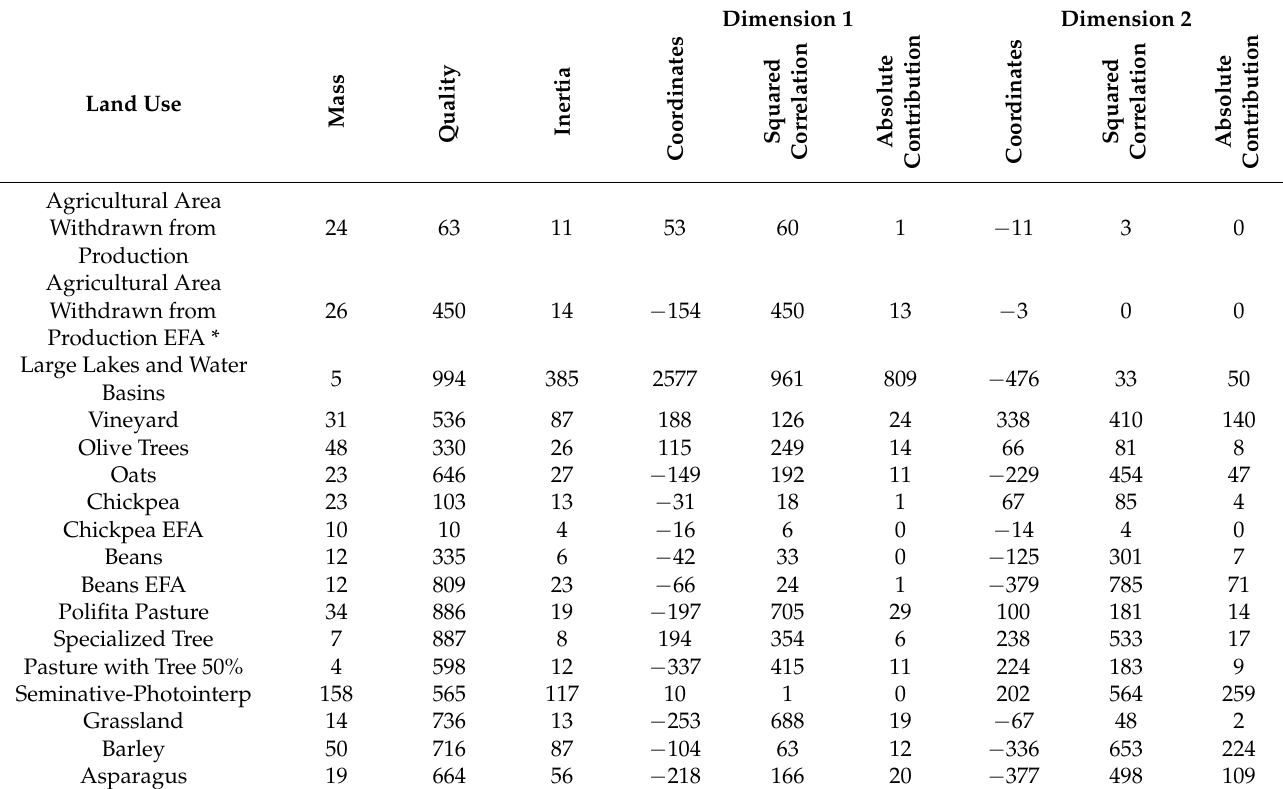
Table 2 is an extract of the summary for the Rows (land use) while Table 3 is the summary for the columns (concentration of isoproturon): Table 2. Results summary for the first